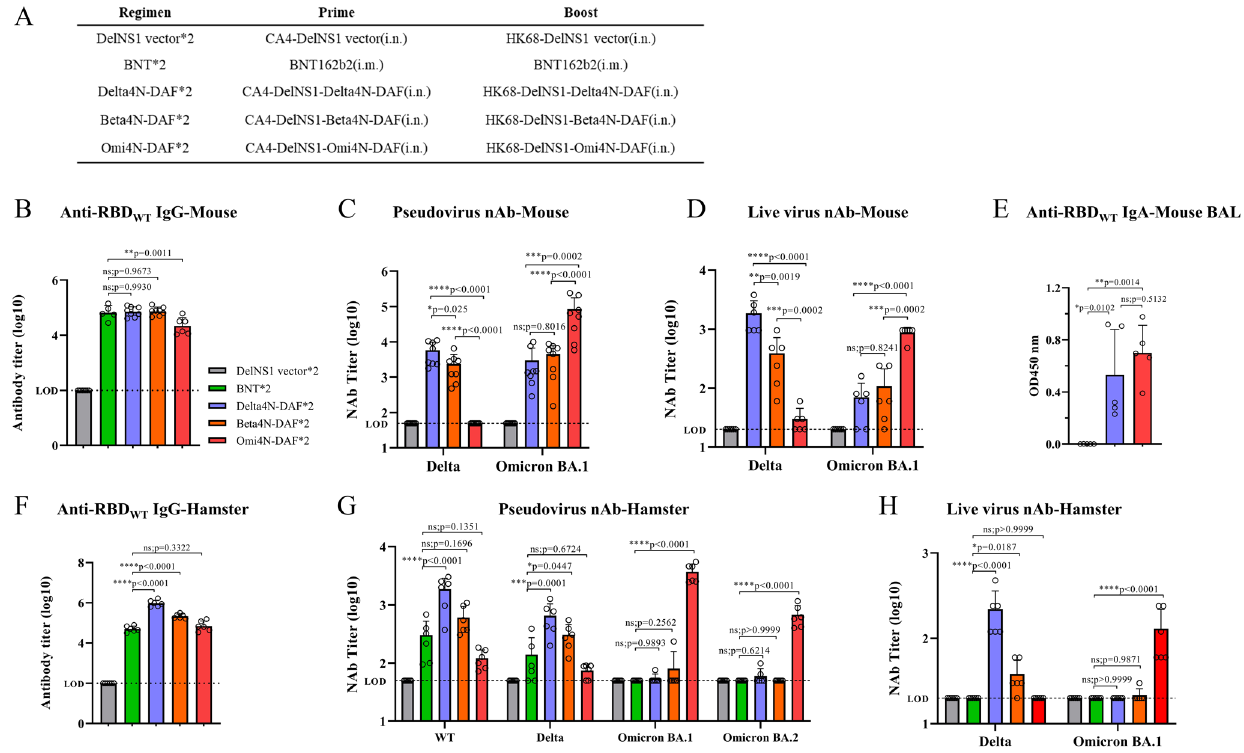
Fig. 2 | Immunogenicity of DelNS1-RBD4N-DAF LAIVs in mice and hamsters. A Prime-boost immunization regimen and grouping of BALB/c mice and hamsters. BALB/cmicewereprime-boostimmunizedintranasallywith2×10 6 pfuofDelta4N- DAF, Beta4N-DAF, DelNS1-RBD4N-DAF with Omicron BA.1 RBD (Omi4N-DAF) or DelNS1 vector only control, or through intramuscular injections of the BioNTech BNT162b2 mRNA vaccine (BNT, 5ugand sera collected 14 days after the second immunization for testing of anti-S1 RBD-speci fi c IgG titers ( B ) (Delta4N-DAF ( n =8 mice), Beta4N-DAF ( n =8 mice), Omi4N-DAF ( n =6 mice), DelNS1 vector ( n =8 mice), BNT ( n =5 mice)). C Neutralization titers against pseudotyped viruses dis- playing Delta or Omicron BA.1 spike proteins ( n =8 mice for each group), and ( D ) neutralization titers against live SARS-CoV-2 variants (Delta and Omicron BA.1) ( n =6 mice for each group). E The bronchoalveolar lavage (BAL) of mice was col- lected 10 days after boost immunization and anti-S1 RBD-speci fi c IgA titers